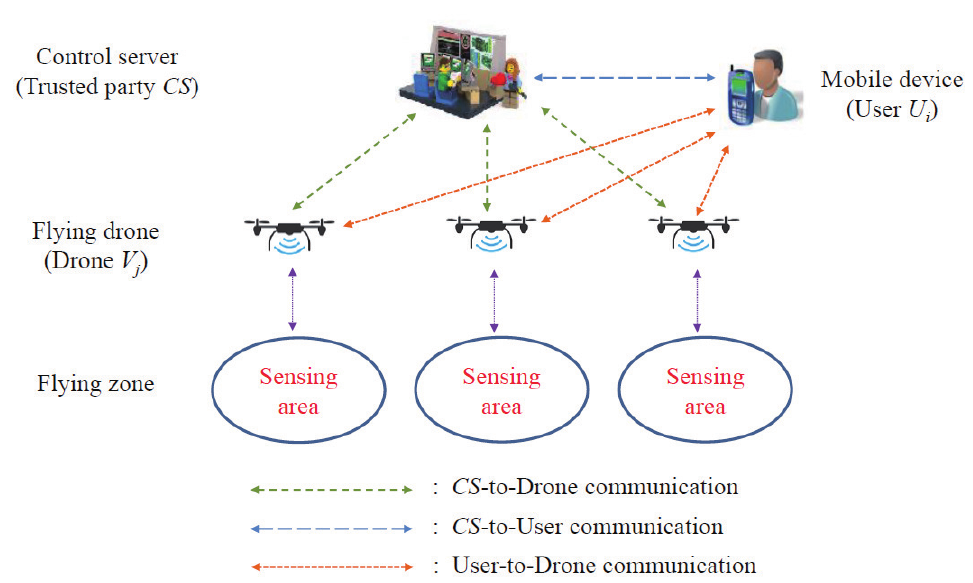
Figure 1. Communication architecture diagram of